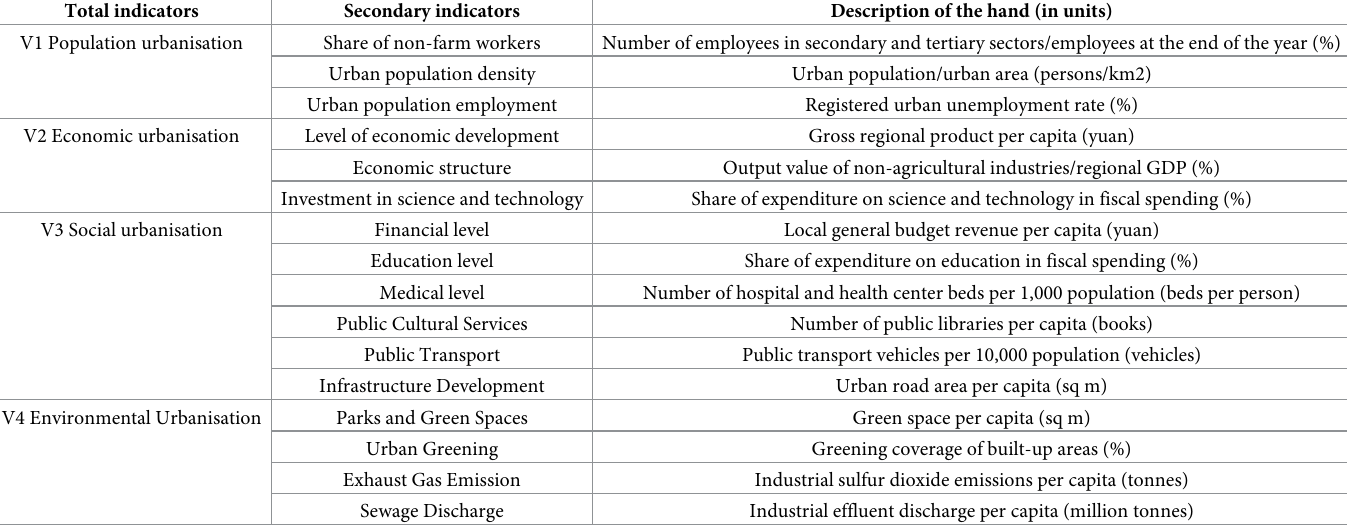
Table 3. Comprehensive evaluation index system of the new urbanization